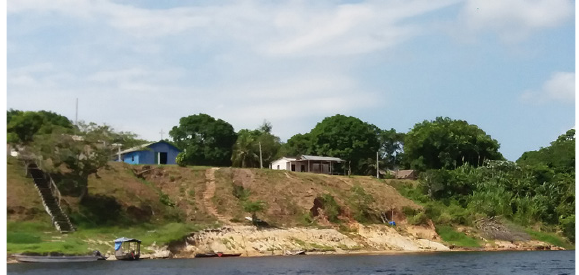
Figure 2. The riverside community of Piloto, Barcelos, Amazonas, Brazil.